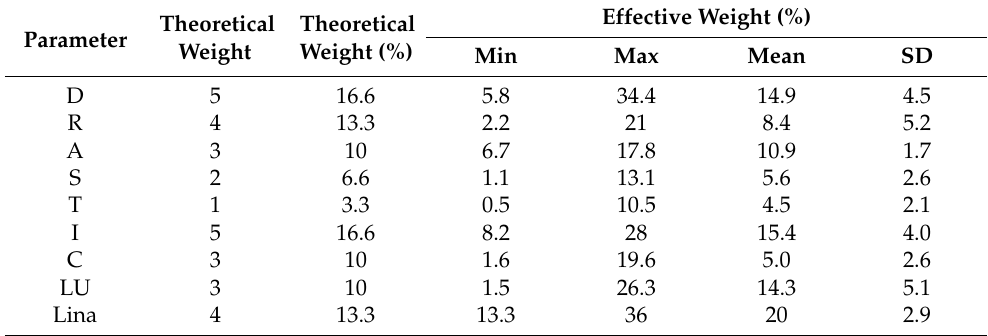
Table 6. Statistical summary of the single-parameter sensitivity analysis of modified